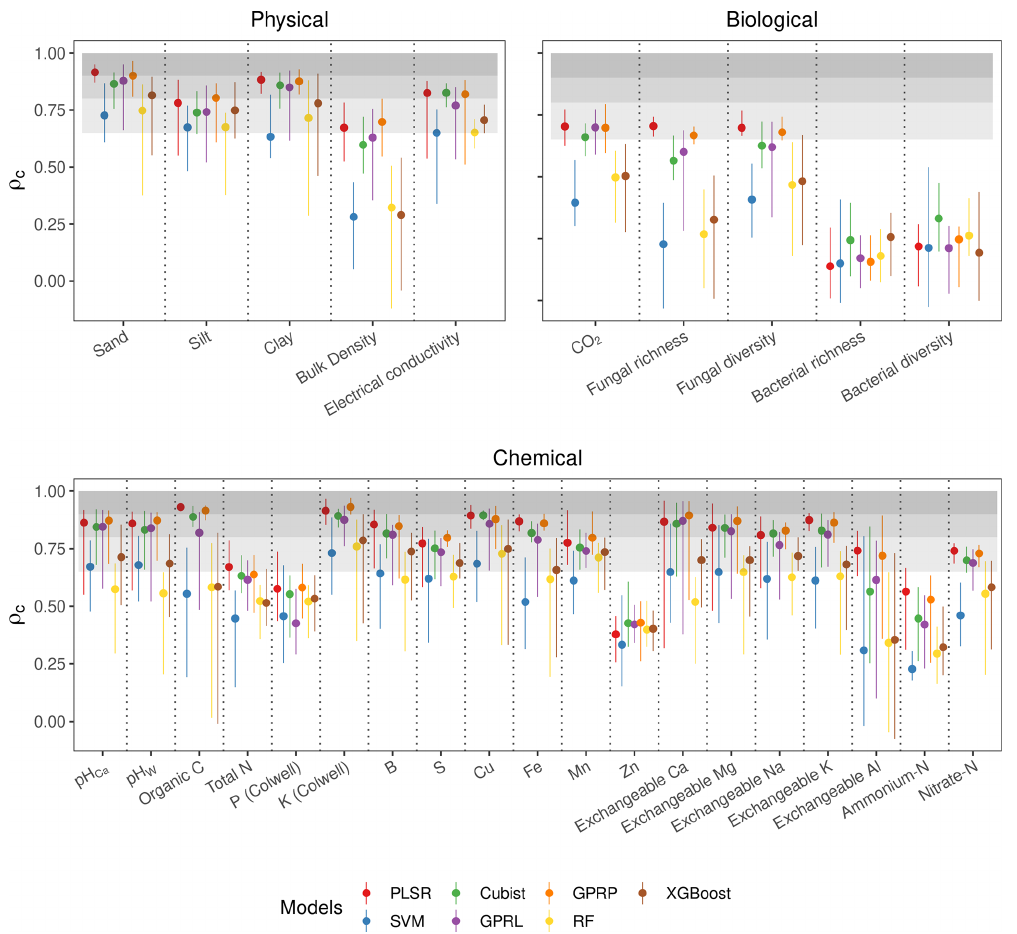
Figure 4. Assessment of the accuracy from different algorithms. The mean ρ c (points) and range (lines) extend the minimum and maximum values of ρ c from the five spectrometers and three combinations. The three shaded grey bands indicate the accuracy level, which we classified as poor ( ρ c < 0 . 65), moderate (0 . 65 ≤ ρ c < 0 . 8), substantial (0 . 8 ≤ ρ c < 0 . 9), and near-perfect (0 . 9 ≤ ρ c ≤ 1 .